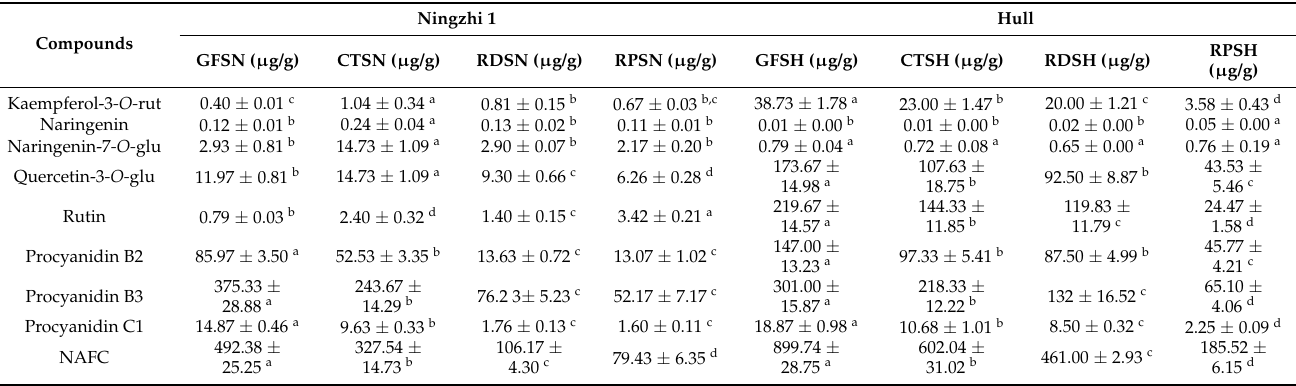
Table 1. Variation of non-anthocyanin flavonoid content in Ningzhi 1 and Hull blackberry fruit at different developmental